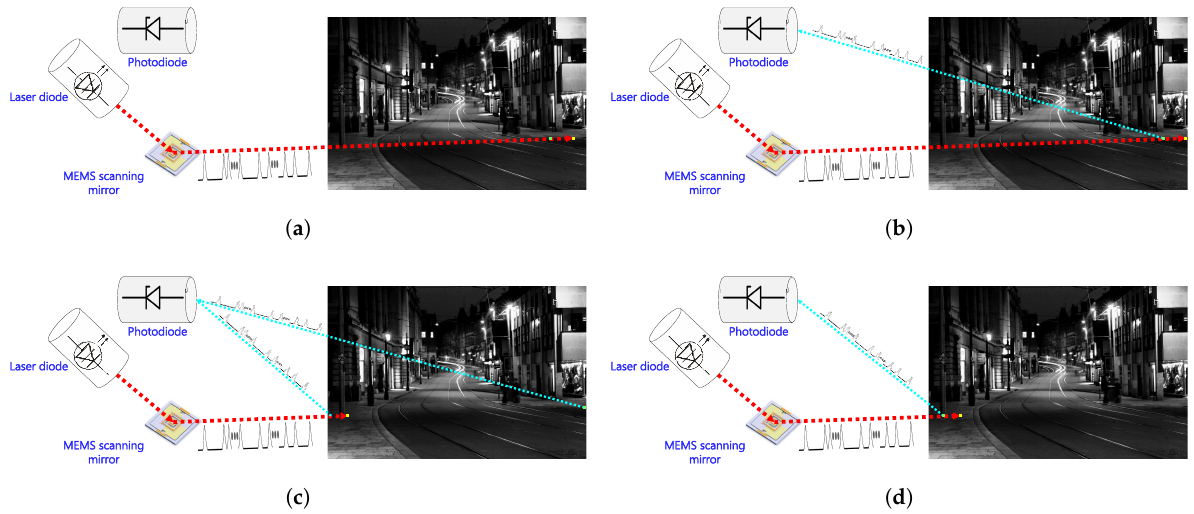
Figure 6. Operating strategy of the scanning LIDAR system with coded pulses. ( a ) The LIDAR fires coded pulse streams at the target, and then, the MEMS mirror is tilted toward the next target; ( b ) the LIDAR fires coded pulse streams at the target, and then, the MEMS mirror is tilted toward the next target. At the same time, the LIDAR receives a reflected pulse stream, decodes it, and then calculates the target distance with the identifier at the received pulse stream. ( c , d ) The LIDAR repeats the ( b ) sequence for all